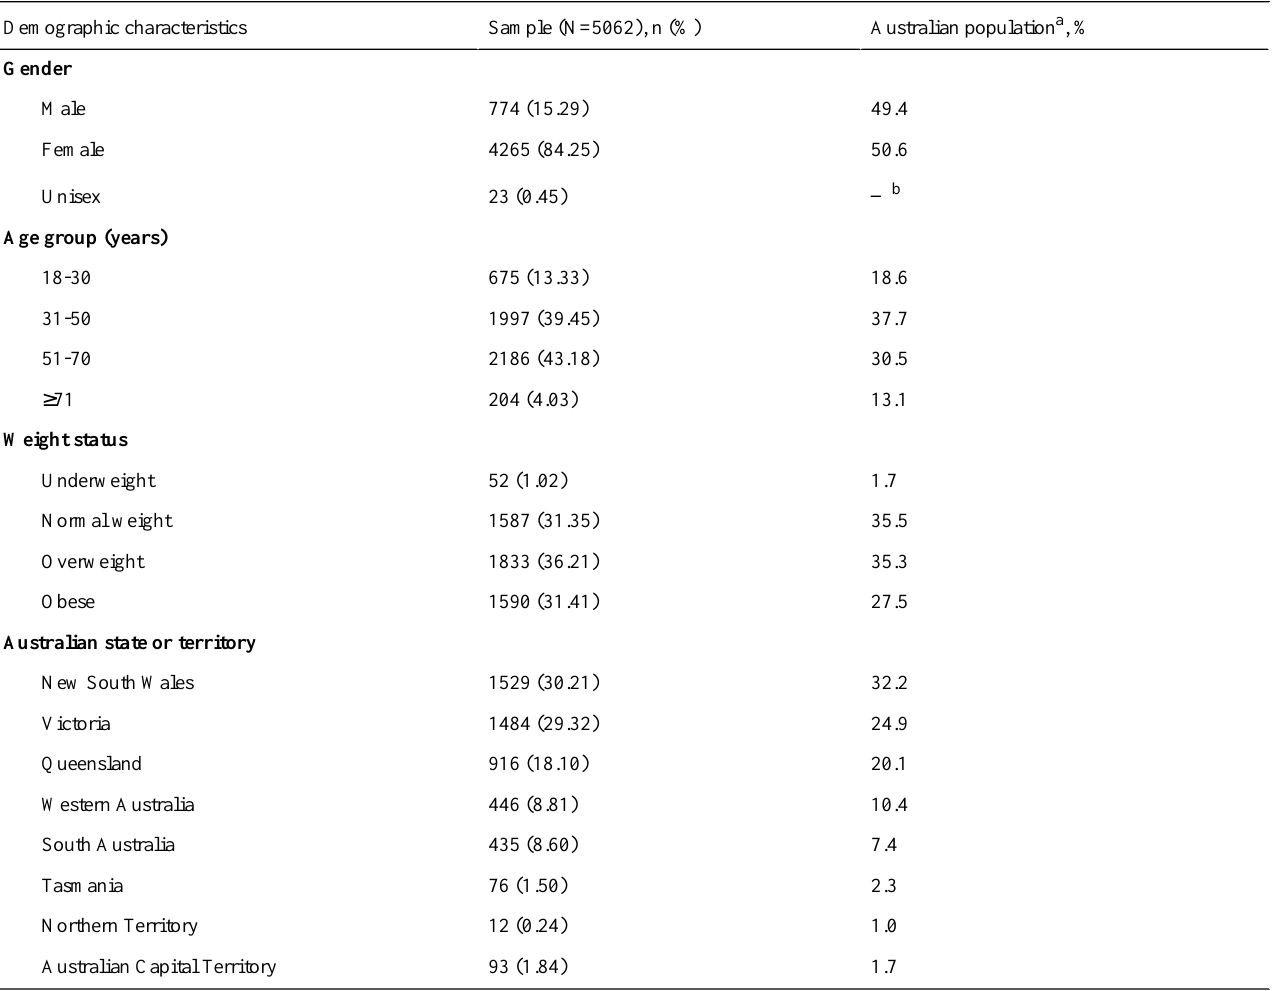
Table 1. Demographic characteristics of the baseline sample of participants and their comparison with the Australian